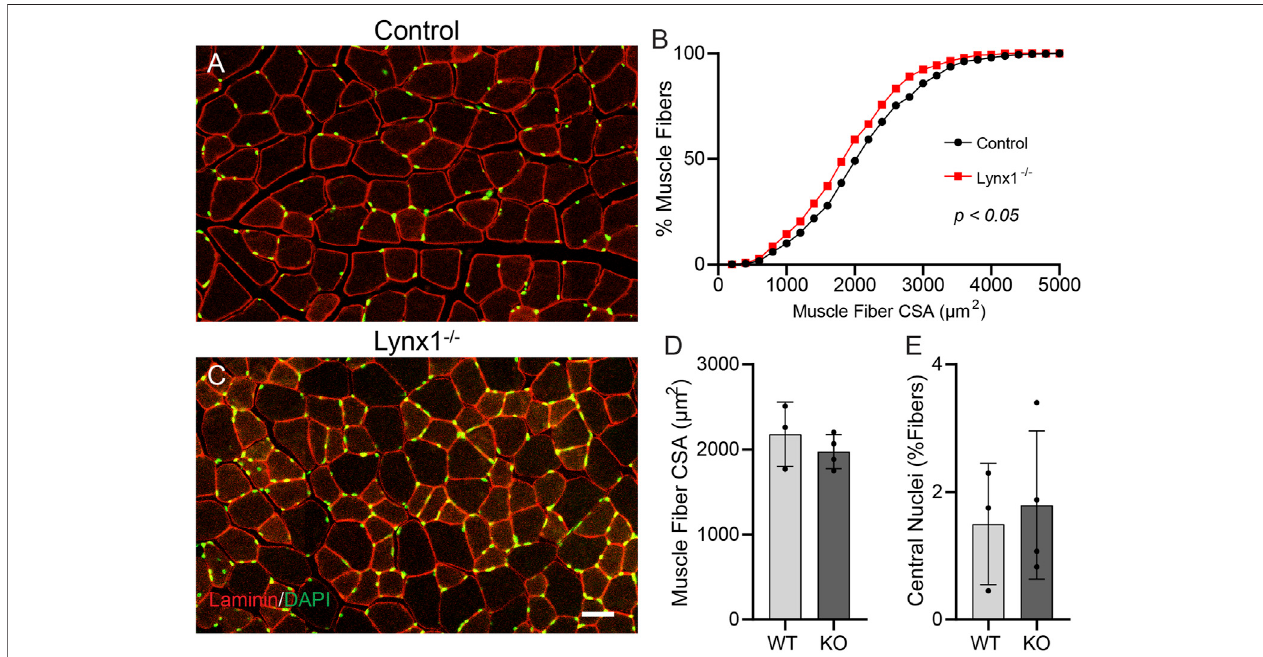
FIGURE 7 | Muscle fi bers are smaller but do not exhibit signs of degeneration in Lynx1 − / − mice. (A,C) Representative images of tibialis anterior (TA) cross sections from 12-month-old control and Lynx1 − / − mice in which muscle fi bers are identi fi ed by laminin (red) and nuclei are labeled with DAPI (green). (B) Cumulative frequency of muscle fi ber cross-sectional area (CSA). p < 0.05, Kolmogorov – Smirnov test. (D) The average muscle fi ber CSA. (E) The percentage of muscle fi bers with a centrally located nucleus. All values are mean ± SD. Scale bar = 50